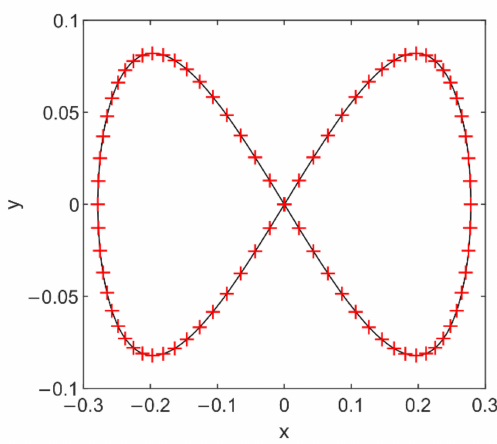
Figure 3. Comparison of homoclinic orbits of the system (6) where the solid curve represents the exact model based on Hamiltonian and the sign + shows the orbits in explicit functions of ϕ